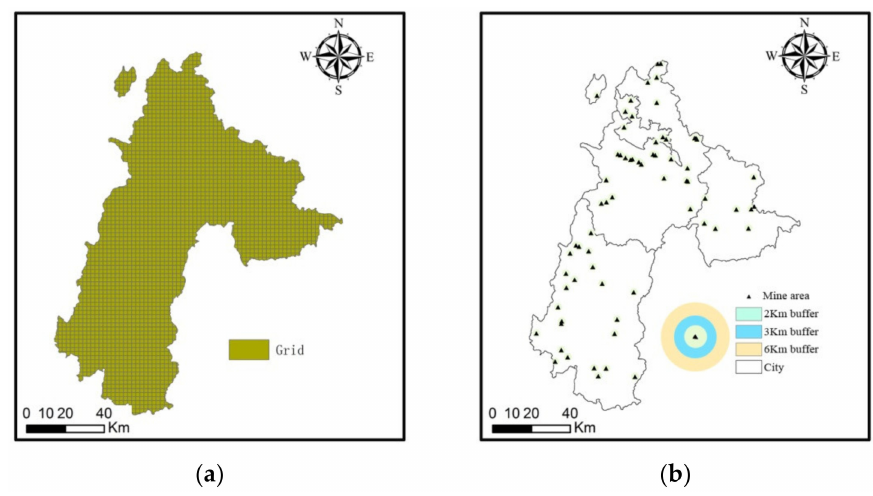
Figure 2. ( a ) The range of Liupanshui ( b ) Mining area and buffer zone in